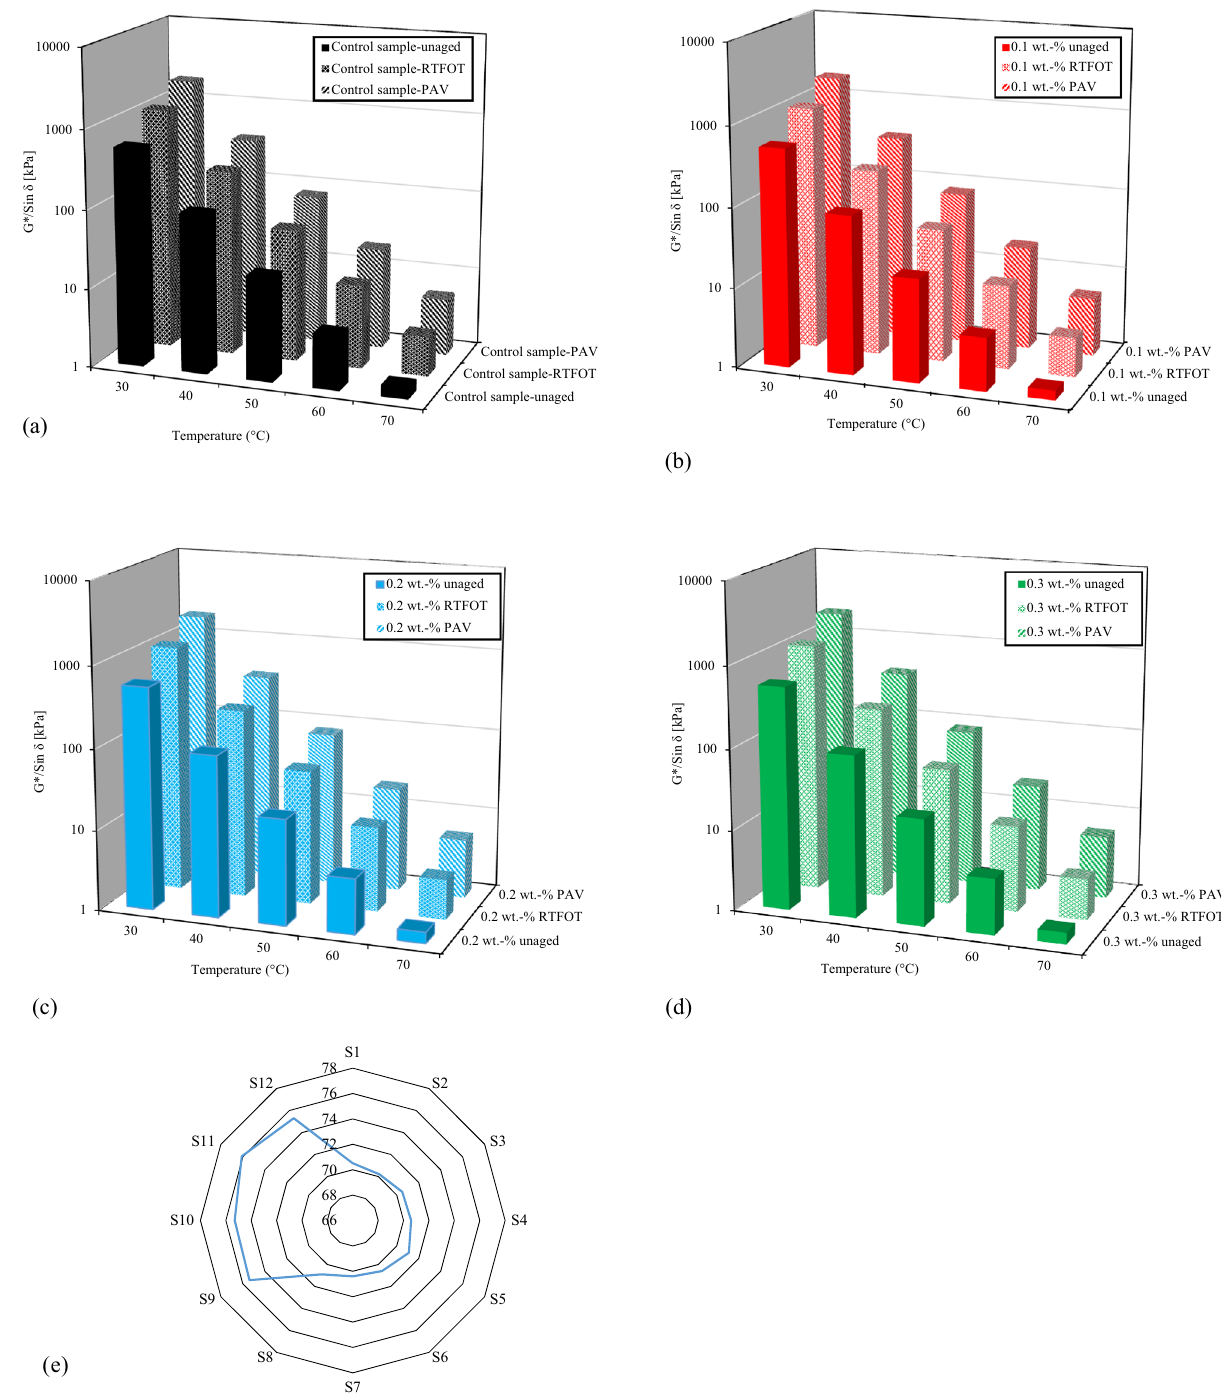
Figure 3. Analysis of Dynamic Shear Rheometer tests—rutting resistance of binder samples before and after aging: ( a ) control sample, ( b ) 0.1 wt.-% fumed silica nanoparticles (FSN), ( c ) 0.2 wt.-% FSN, and ( d ) 0.3 wt.-% FSN. ( e ) Binder threshold temperatures (°C) for rutting resistance considering different concentrations of FSN before and after aging, G*/sin δ = 1 kPa for before aging and G*/sin δ = 2.2 kPa for after